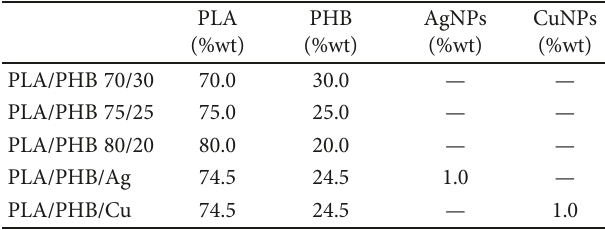
Table 2: Proportions of components used for each blend